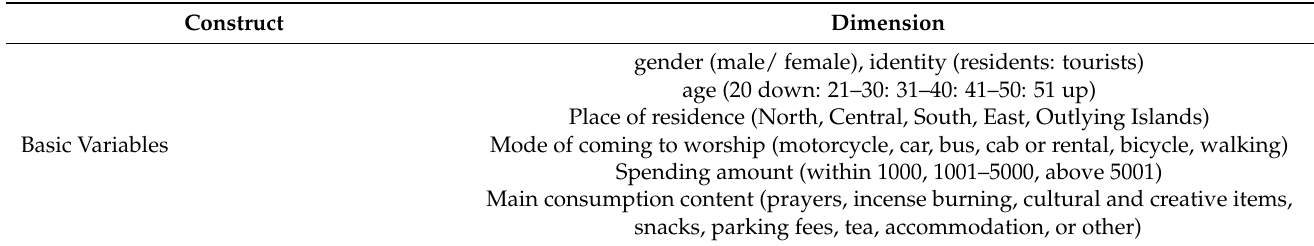
Table 1. Classification table of tourism impact